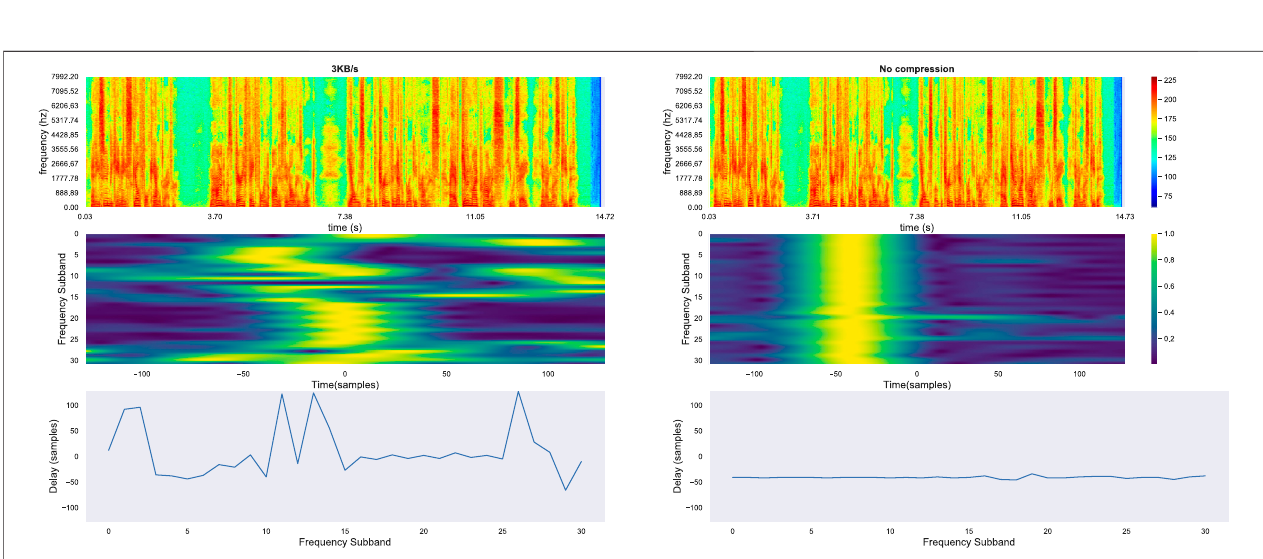
FIGURE 11 | 1 st row: Spectrograms for one uncompressed test utterance channel and its EVS-encoded versions at various bitrates [8, 16.4, 32, 128]kB/s. 2 nd row:Frequency-slidedCPSinputfeaturecomputedbetweentwosegmentsoftheencodedchannels.3 rd row:argumentofthemaximumofCPSineachfrequencyband corresponding to the delay (samples) between the two channels.